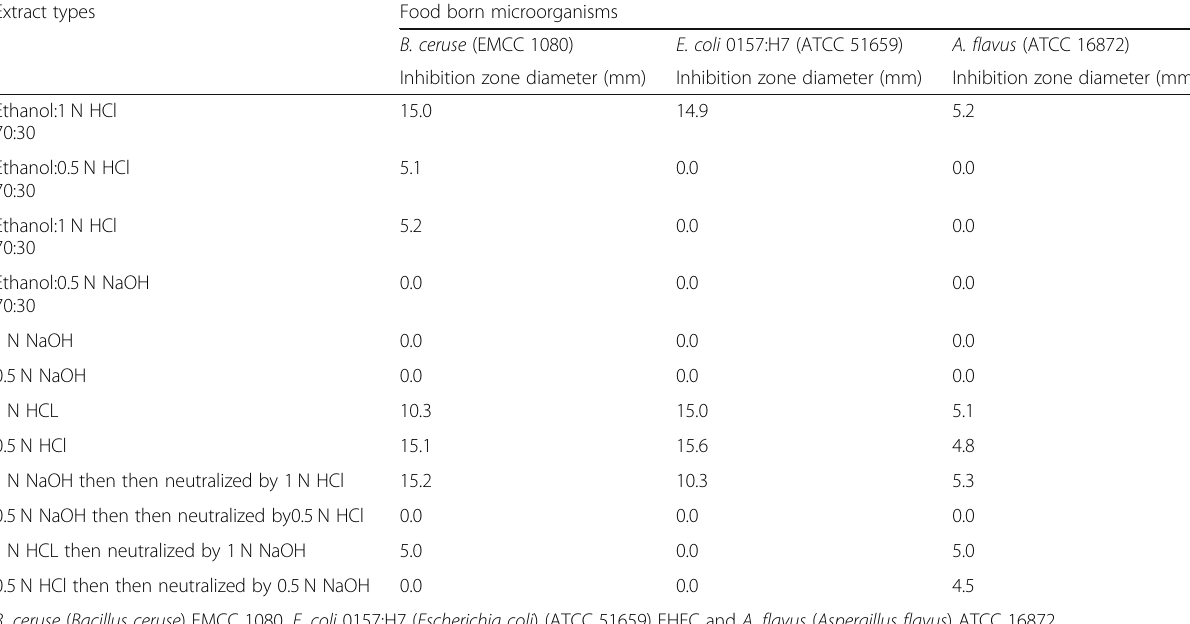
Table 5 Antimicrobial effect of jojoba hull extract on the inhibition growth of food born microorganisms Extract types